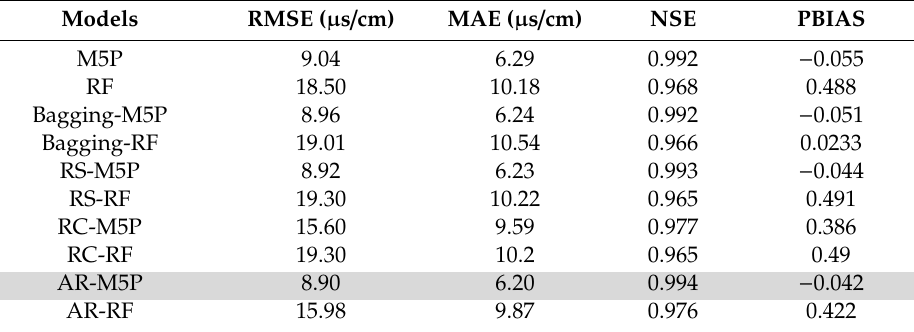
Table 5. Quantitatively statistical criteria for model validation in testing